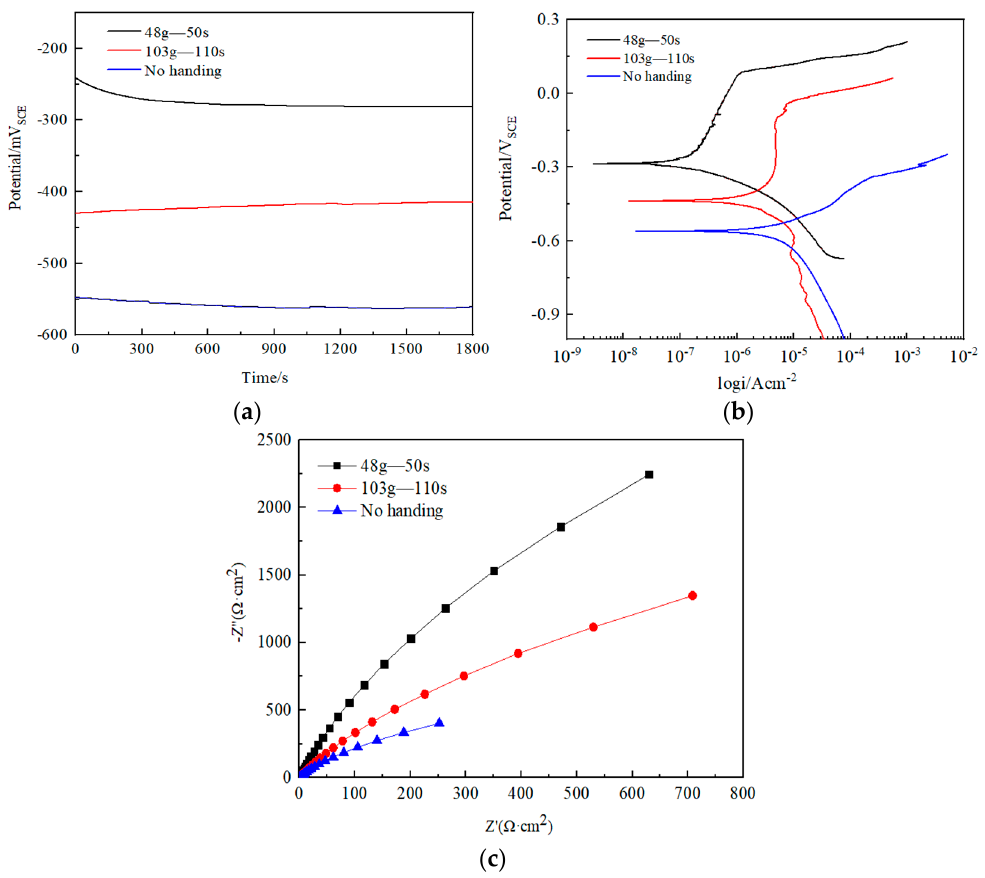
Figure 8. Results from electrochemical measurements. ( a ) the OCP versus pickling treatment parameters, ( b ) potentiodynamic polarization curves, and ( c ) Nyquist plots of the tested samples. Table 2. Corrosion current densities of the pre-passivation films with different pickling conditions. Pickling Parameters